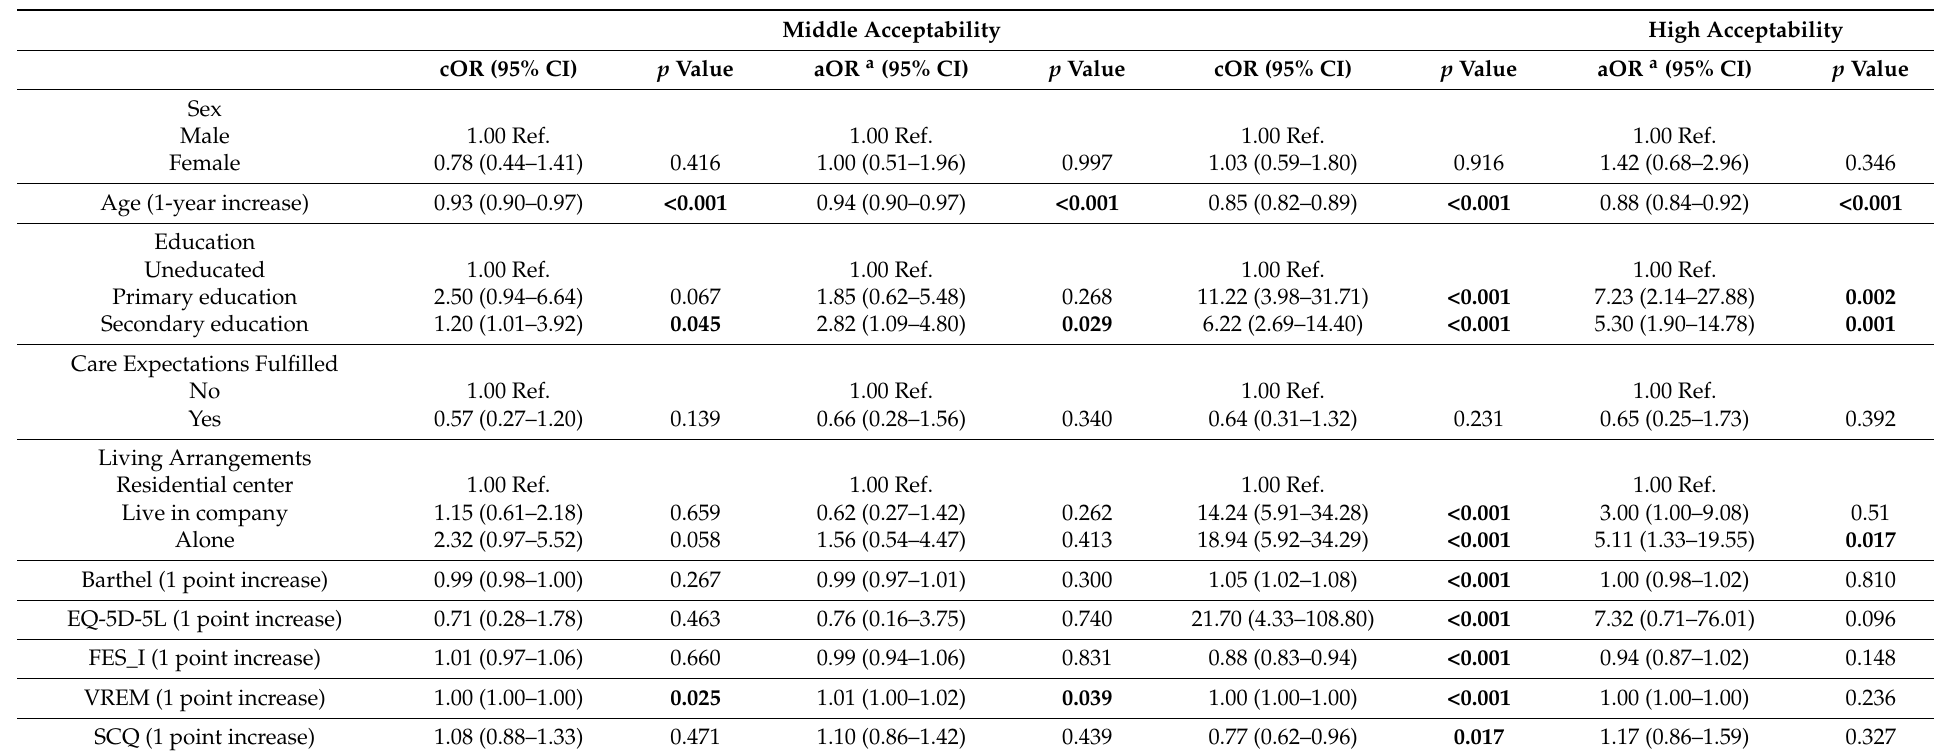
Table 6. Multivariate analysis of the degree of acceptance of the use of new